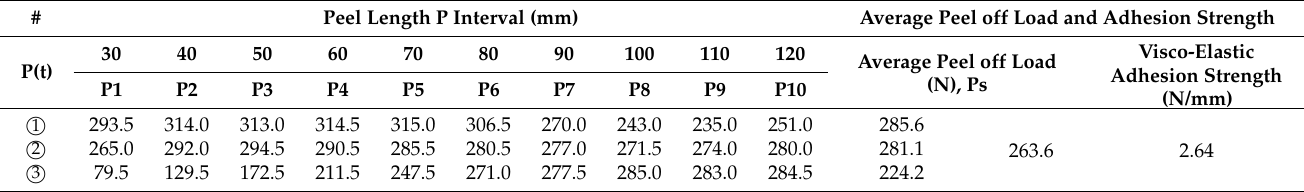
Table 6. VG-2 Viscoelastic adhesive strength test